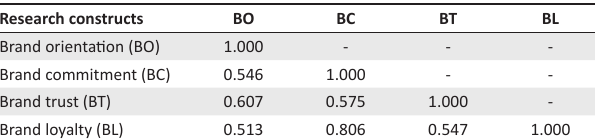
TABLE 3 : Correlation between the constructs. Research